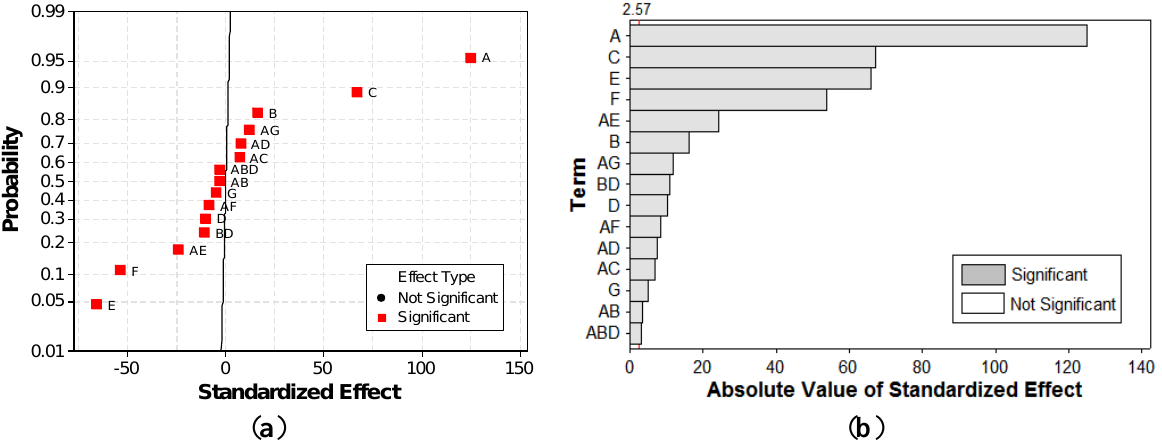
Figure 10. Normal plot of the ( a ) standardized effects; and ( b ) standardized Pareto chart for UED response.